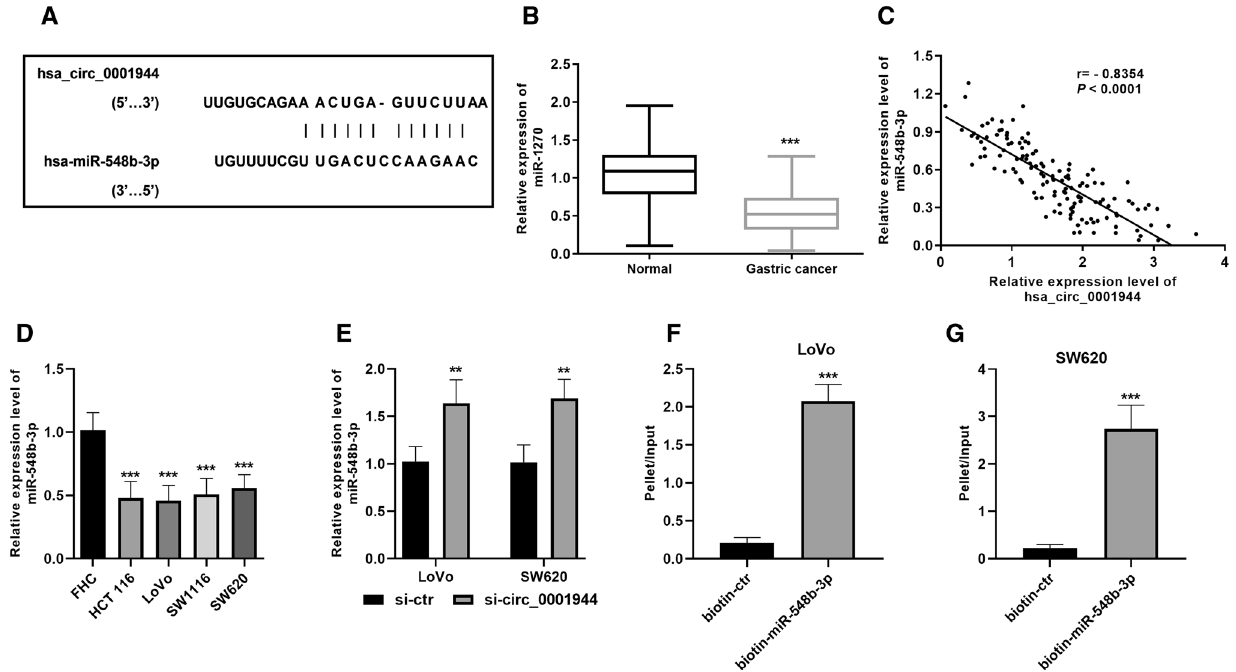
Fig. 3 Hsa_circ_0001944 binds to miR-548b-3p. A The binding sites were predicted in Interactome. B miR-548b-3p was downregulated in CRC tissues. Paired t-test was applied. C The expression of hsa_circ_0001944 was negatively correlated with the expression of miR- 548b-3p in CRC tissues (n = 133). Pearson correlation assay was applied. D miR-548b-3p was downregulated in CRC cells. E Inhibition of hsa_circ_0001944 increased the level of miR-548b-3p in CRC cells. Student t-test was applied. F , G RNA was affinity-isolated by biotinylated miR-548b-3p using biotinylated miRNA pull-down assay, and the hsa_circ_0001944 was quantified by qRT-PCR and normalized to input. Student t -test was applied. Error bars are mean ± standard error from at least three replicate samples. ** P < 0.01, *** P <